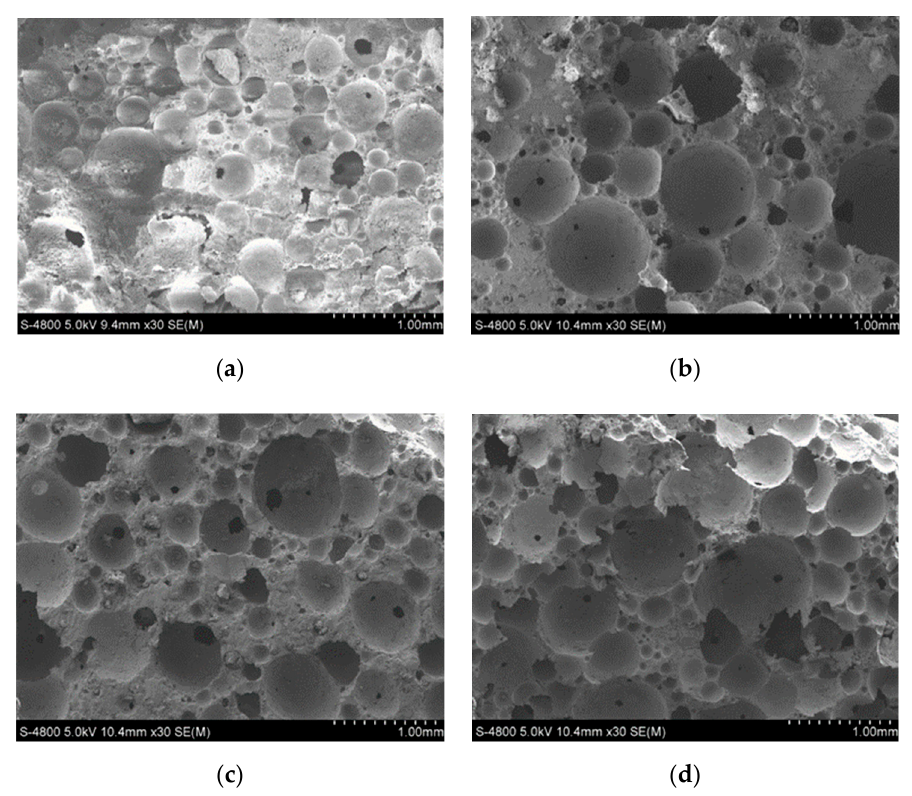
Figure 8. SEM images of pore structure of mixes with different silt content: ( a ) SC0; ( b ) SC20; ( c ) SC30; ( d ) SC40.